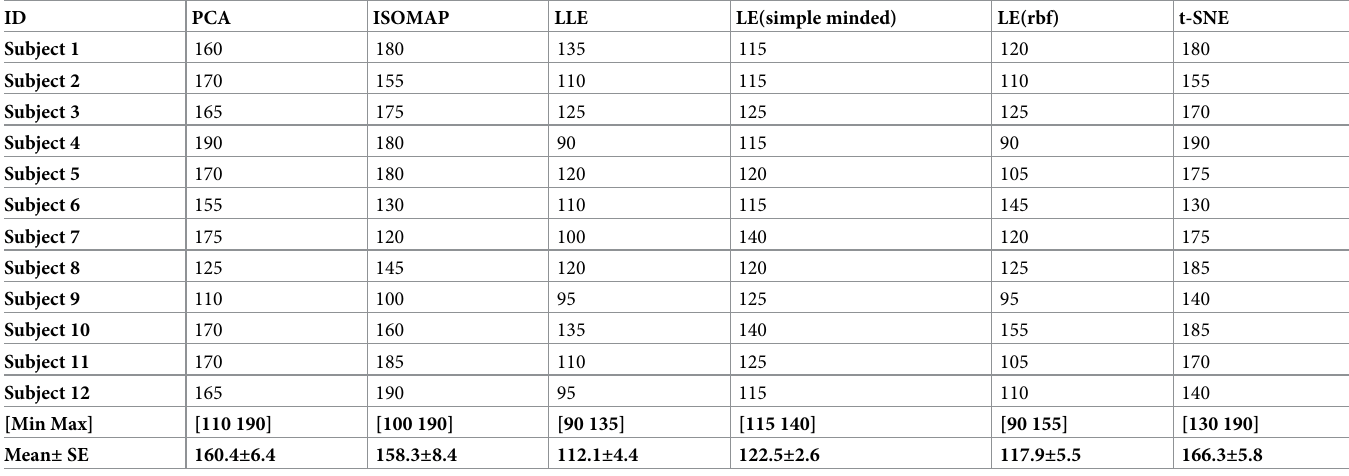
Fig 6. Visualization of the effect of k (top row) and σ (bottom row) on the training dataset for Subject 1 in the embedded space. https://doi.org/10.1371/journal.pone.0255926.g006 (MLE) as the intrinsic dimensionality estimator in the Matlab toolbox for dimensionality reduction [39]. The number of eigenvectors varied between 110 and 170 over the 12 subjects for different dimensionality-reduction techniques. We also visualized the embedded EMG using our six dimensionality-redution methods (PCA, LDA, ISOMAP, LLE, Laplacian Eigenmaps, and t-SNE). Fig 7 shows the 2 most prominent components for each of these methods. Table 2. The number of dimensions that leads to the highest F1-score (obtained using grid search; for k-NN, which was the best classifier; see also Fig 8) vs. different dimensionality reduction techniques for each subject. The mean and standard error (SE) over all subjects for the different methods are also